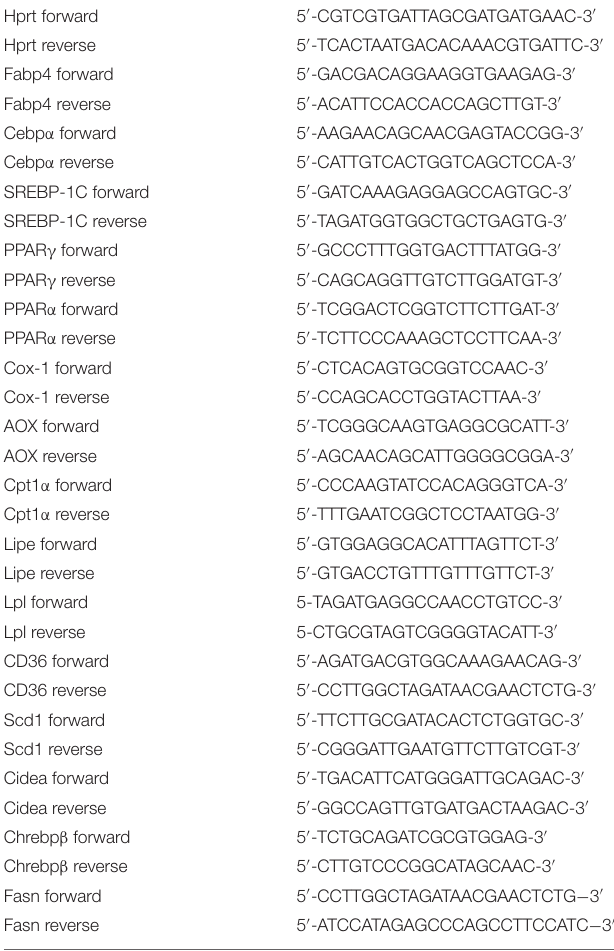
TABLE 1 | Primers for real-time